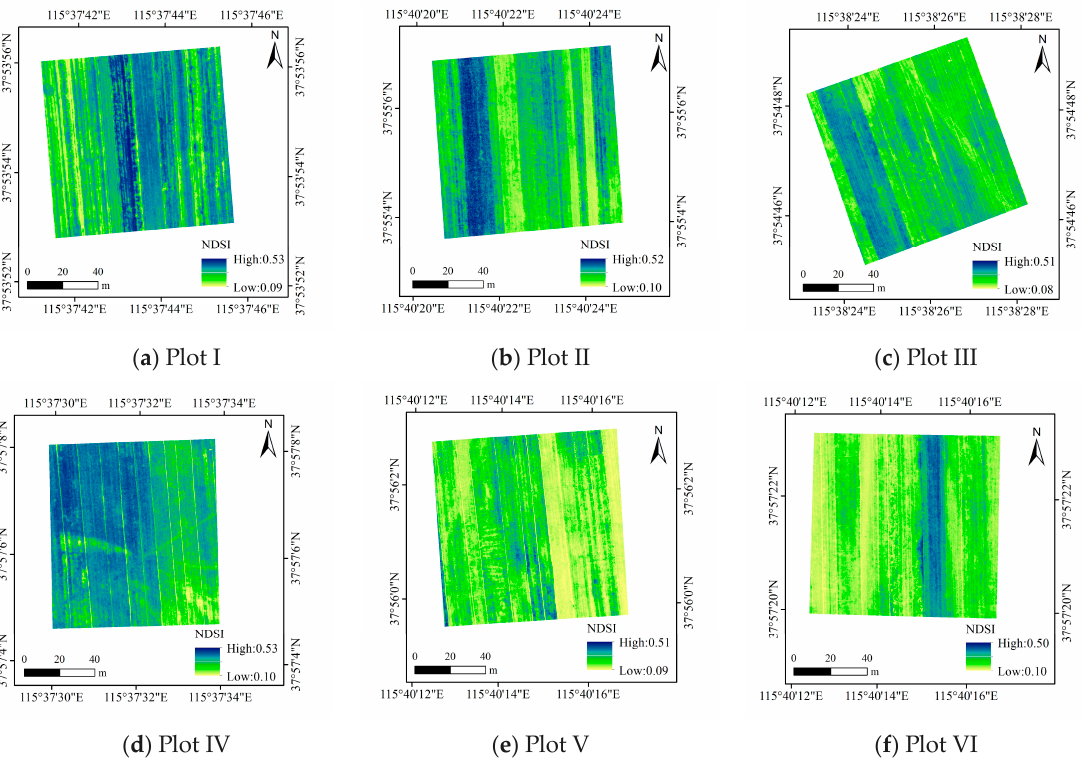
Figure 8. NDSI results of each flight plot based on the sensitive band centers λ (724 nm, 784 nm) (4 June 2021).